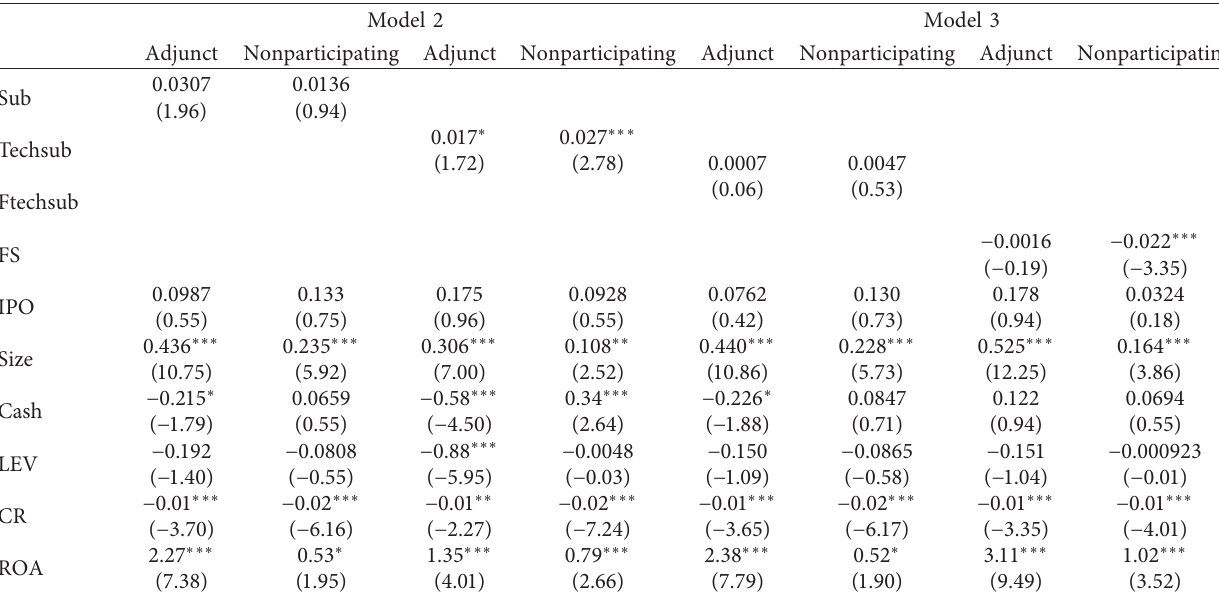
Table 7: Grouping study of corporate governance